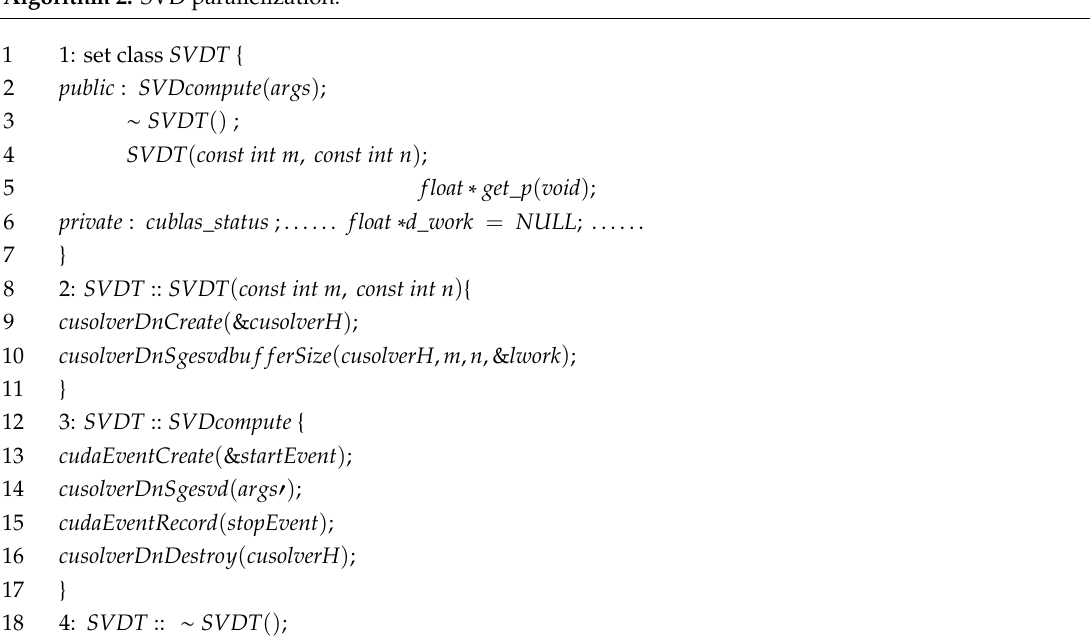
Algorithm 2: SVD